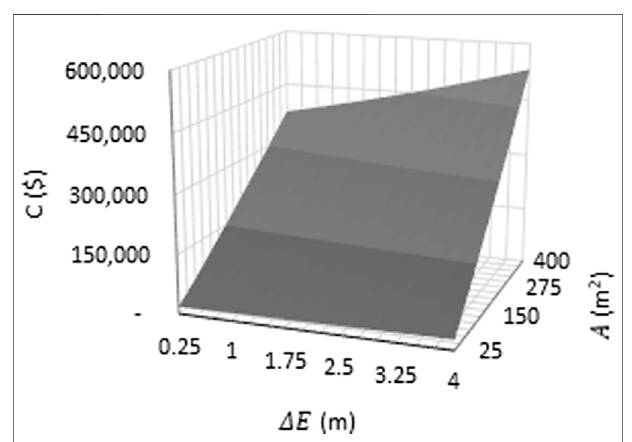
FIGURE 6 | Three-dimensional plot of the Model 5 m prediction based on A and Δ E for one-story homes with slab foundations.